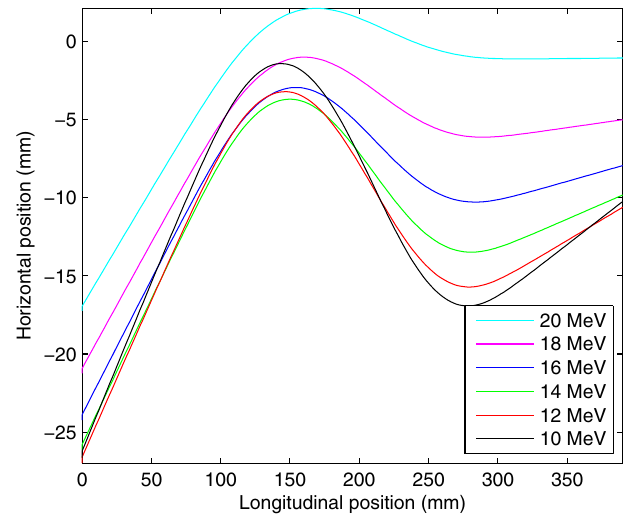
FIG. 4. Closed orbit in a single EMMA cell, at selected refer- ence energies from 10 to 20 MeV. The reference trajectory [ x ð s Þ ¼ 0 ] is a modification of the 42-sided polygon, in which each side is extended back from a vertex to the middle of the drift between the magnets. The complete transfer map for a cell then involves a coordinate transformation at the exit of the cell, consisting of a horizontal translation and a rotation: the effect of this transformation is to restore the position and angle of each trajectory at the exit of the cell (the right-hand edge of the plot) to the position and angle at the entrance of the cell (the left-hand edge of the